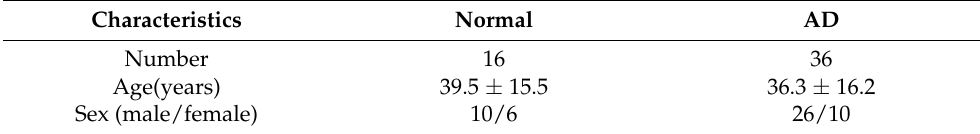
Table 1. Characteristics of human samples.